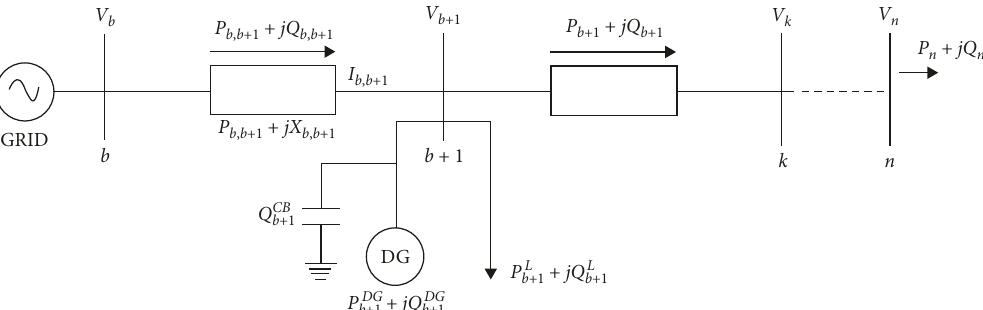
Figure 1: Single-line diagram of RDN with DG and SC installed at a